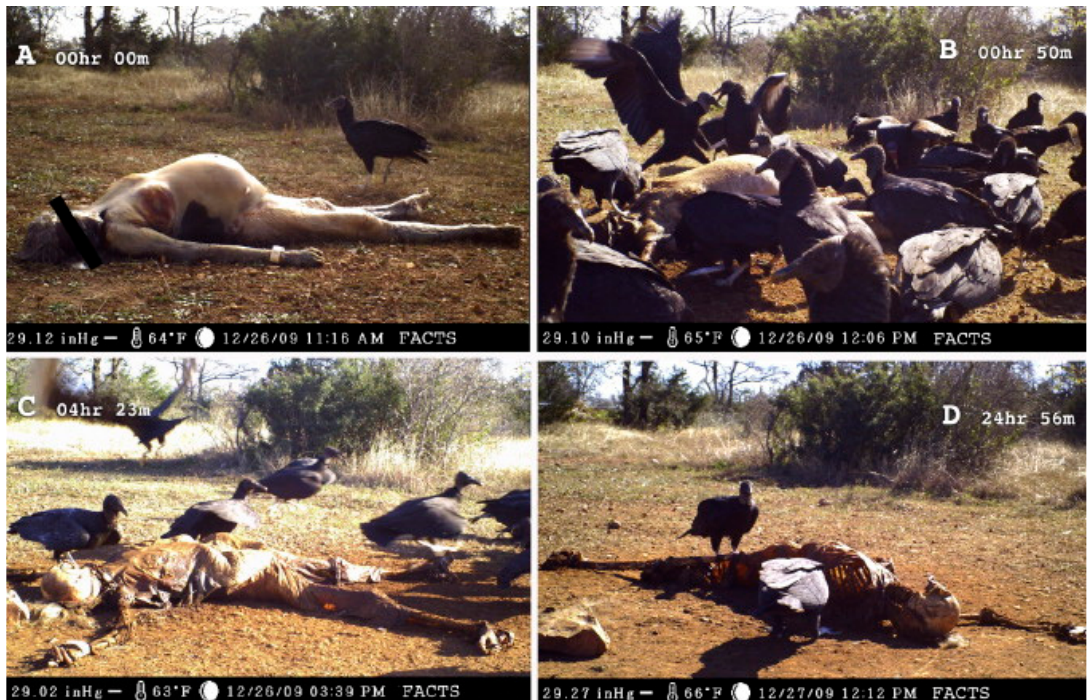
Figure 12. Vultures scavenging donated human remains at the Forensic Anthropology Research Facility (FARF) in Texas. The images show the remains at deposition ( A ), after one hour ( B ), after over four hours ( C ), and after ca. 24 h ( D ). Note the largely skeletonised body, with the bones preserved in anatomical order through soft tissue remnants. Reproduced with permission from Spradley et al. [21]; published by Elsevier, 2012.